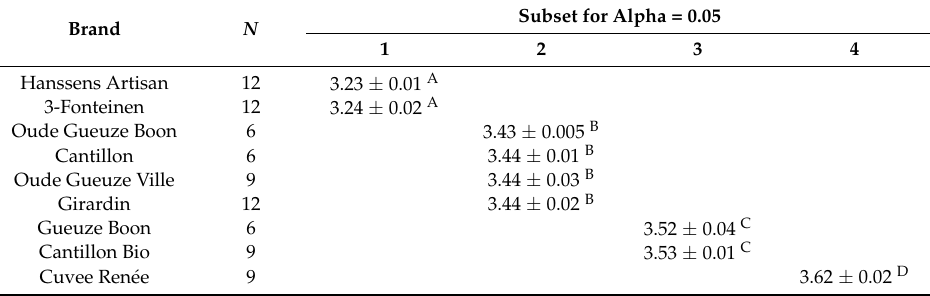
Subset for Alpha =